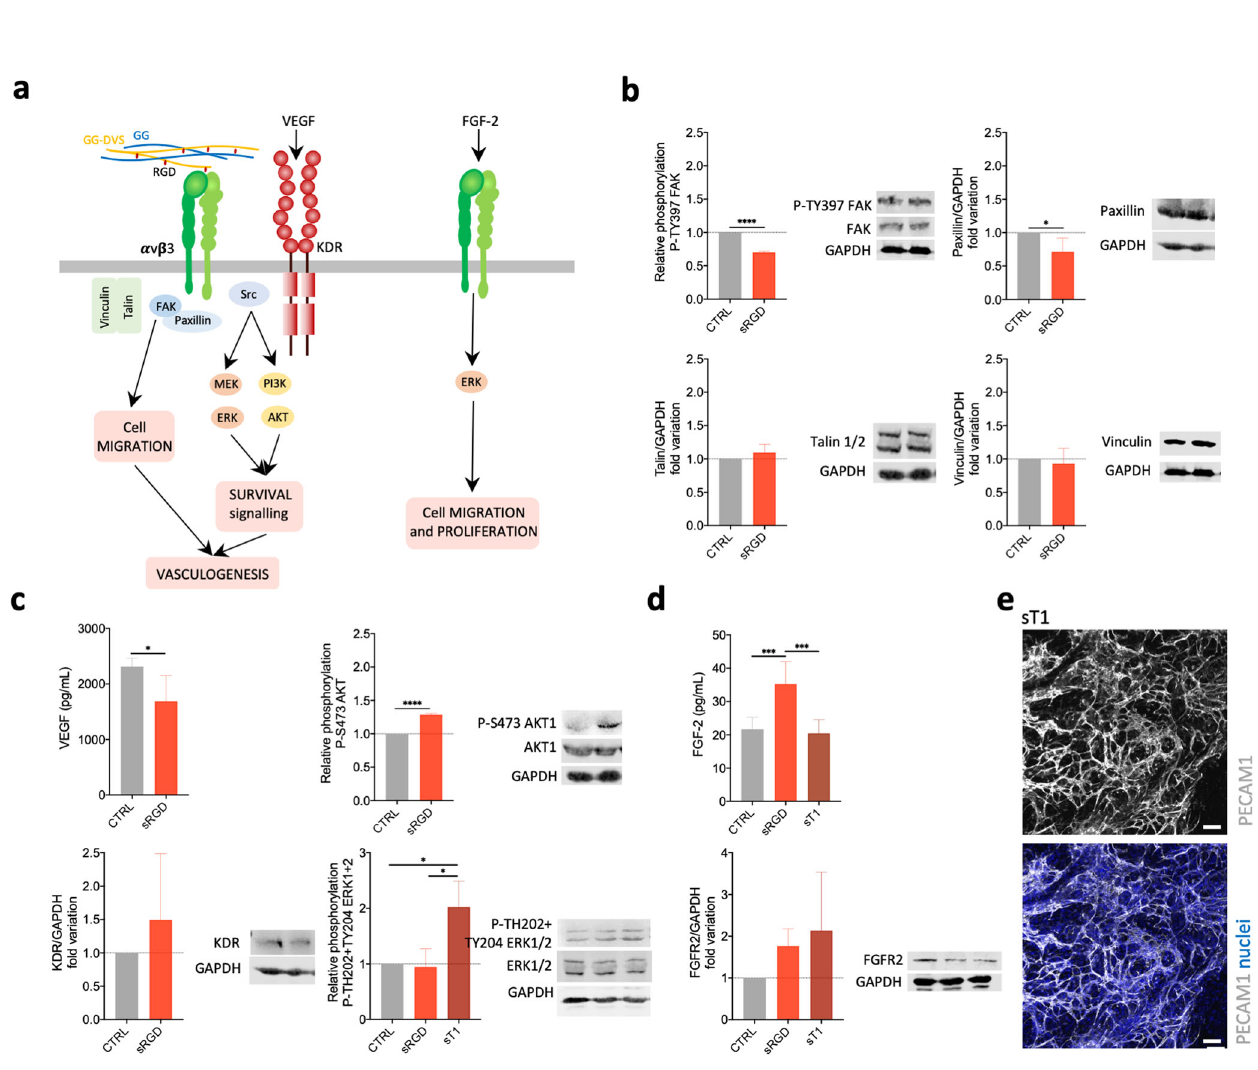
Fig. 4 Involvement of VEGF and FGF2 pathways in the vasculogenesis in integrin-speci fi c spongy-like hydrogels. a Schematic representation of the studied signaling pathways. b Expression of P-TY397 FAK, FAK, Paxillin, Talin 1 + 2. c VEGF secretion, and KDR, P-TH202- TY204 ERK1/2, ERK1/2, P-S473 AKT1, and AKT1 expression. Expression of the proteins ( b , c ) was determined by western blot in SVF cells, with and without pre-incubation with RGD peptide, cultured in the 0.75% GG/GGDVS-RGD materials for 7 days. Expression of P-TH202-TY204 ERK1/ 2, ERK1/2 was also determined when SVF cells were pre-incubation with T1 peptides. d FGF-2 secretion and FGFR2 expression determined by western blot in SVF cells, with and without pre-incubation with RGD and T1 peptides, cultured in the 0.75% GG/GGDVS-RGD materials for 7 days. All plotted western blot data was determined in relation to GAPDH expression. e Representative images of the organization of SVF PECAM1 + cells after 7 days of culture in the 0.75% GG/GGDVS-RGD when pre-incubated with T1 peptide. Results are expressed as the mean ± standard deviation where n = 3, * p < 0.05, ** p < 0.01, *** p < 0.001, **** p < 0.0001, one-way ANOVA with Tukey multiple comparison post-test or two-tailed unpaired t